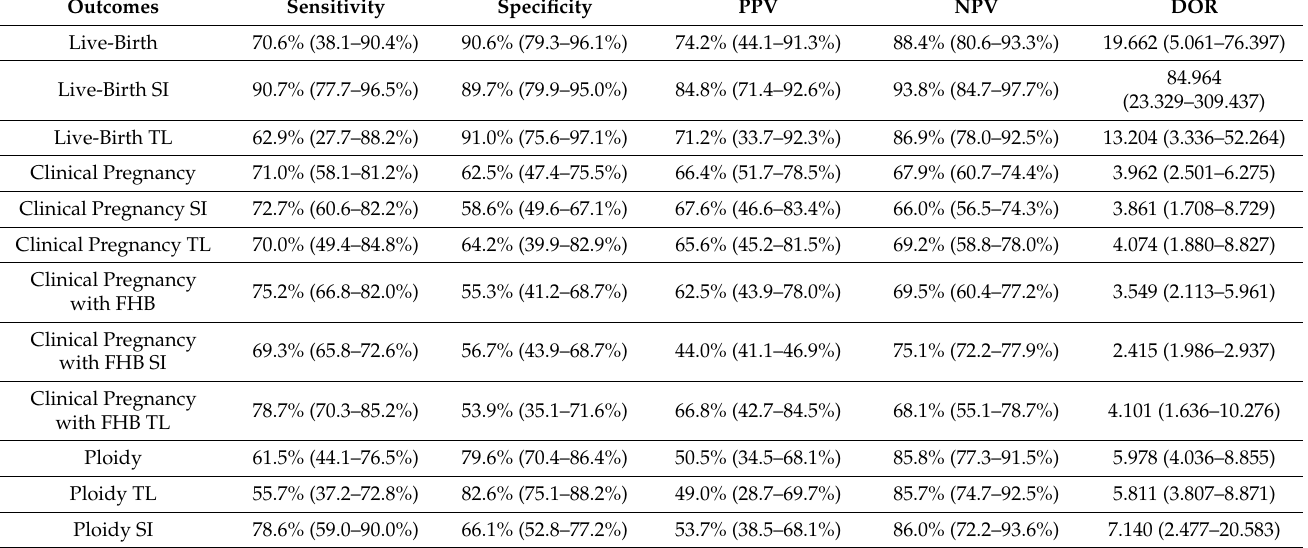
Table 3. Summary of the